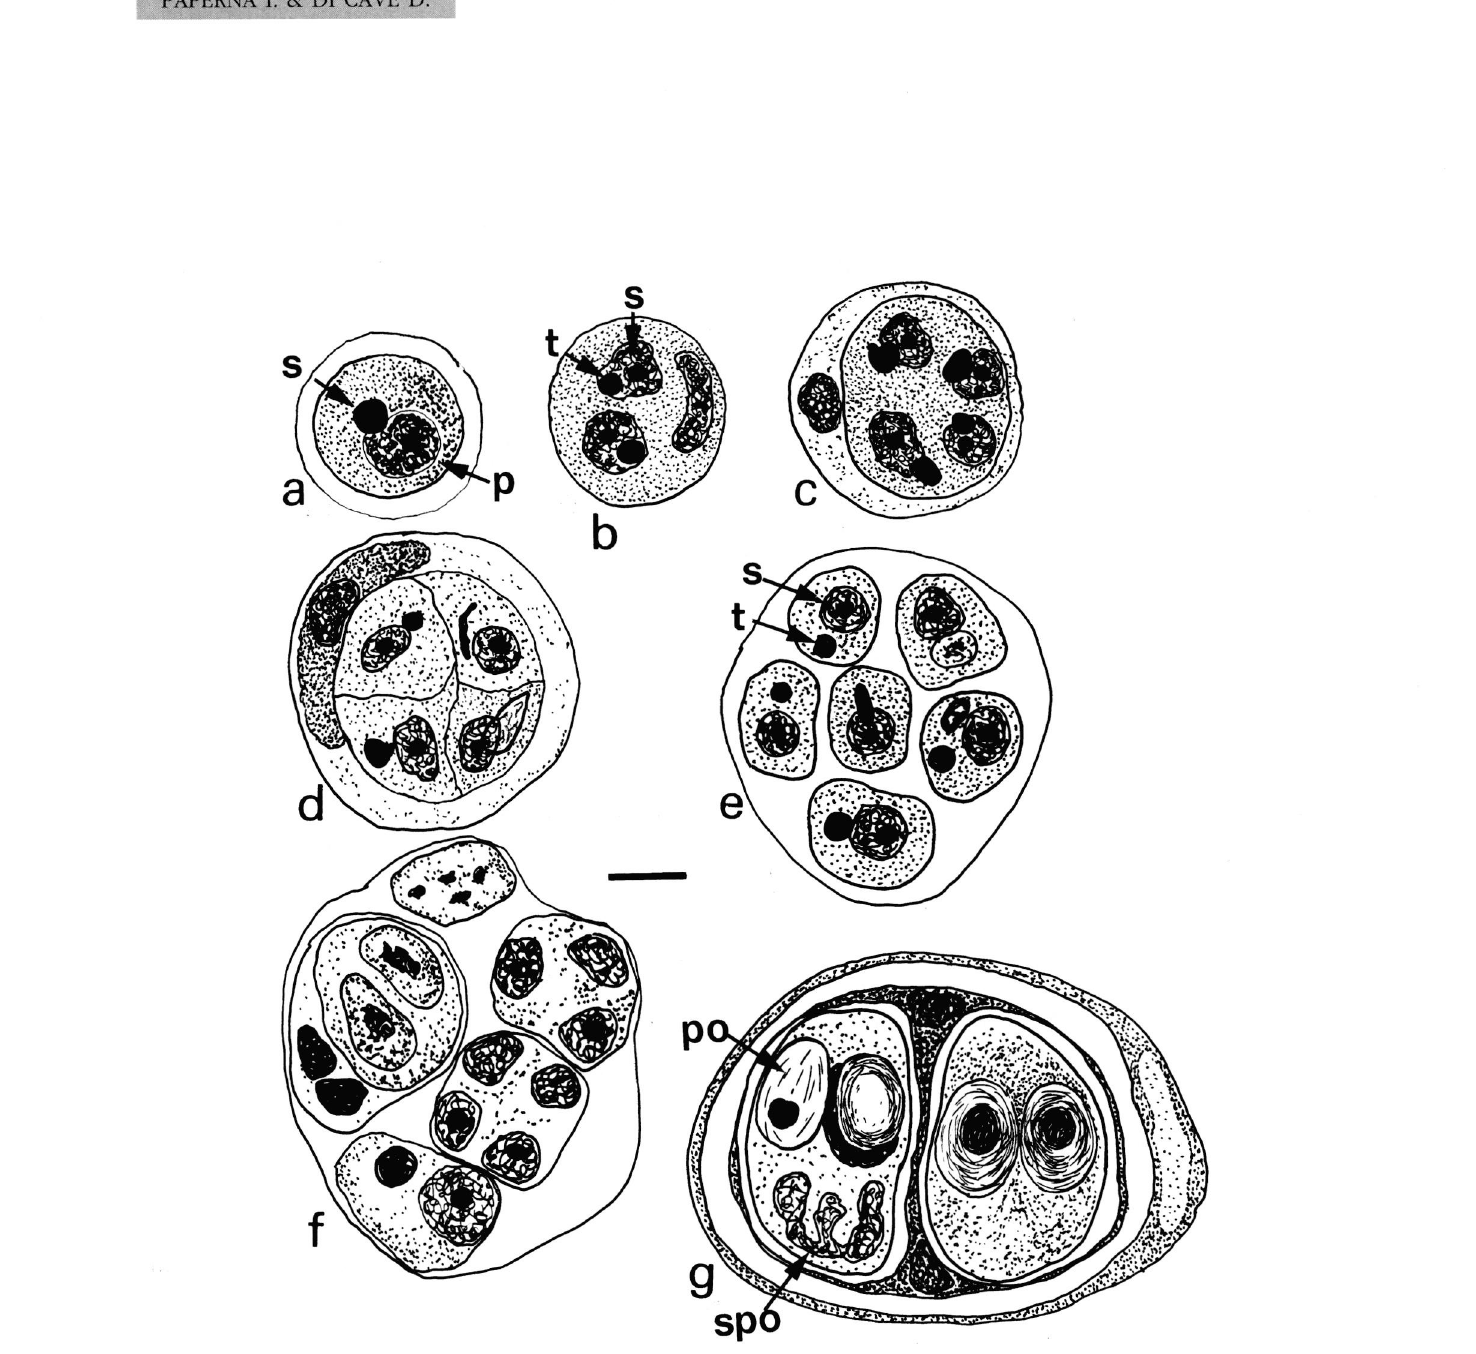
Fig. 1. - Developmental stages of Sphaerospom sp. from Baryancistrus sp., drawn from a Giemsa stained kidney touch preparation, a. Iini- tial stage with one primary (p) and one secondary cell nucleus (s); b. with one primary elongate and two secondary cell nuclei (s), each enclosing a tertiary cell nucleus (t); c. Differentiation of the secondary cell; d. with the secondary cell in division; e. with division com­ pleted (s, secondary and t, tertiary cell nuclei); f. further division of secondary cell progeny; g. bisporoblast from the glomerulus, showing sporoplasm (spo) and polar cells (po). (Scale = 1 um).